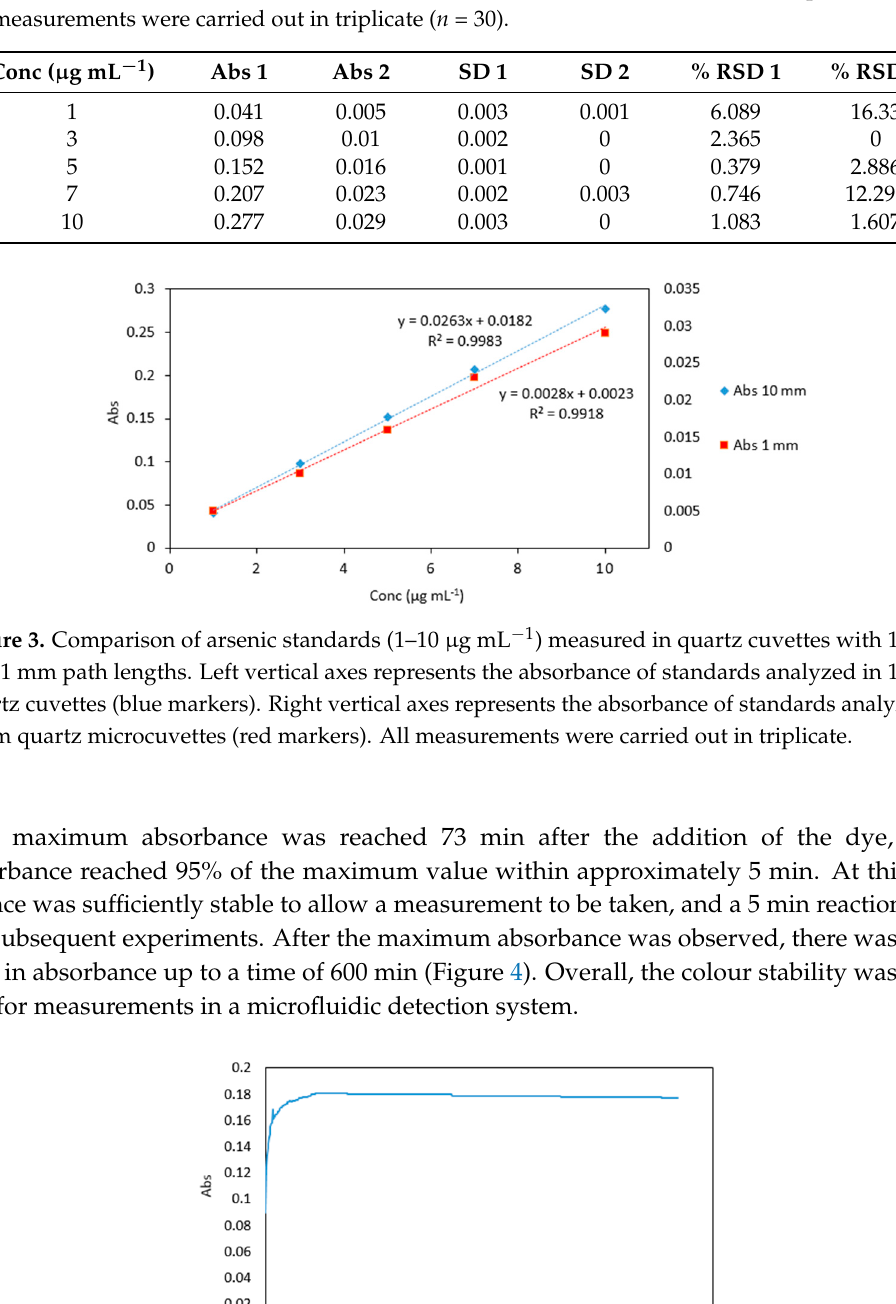
Table 2. Effect of foreign species on the determination of arsenic (III) (1 μ g mL − 1 ). Interferents